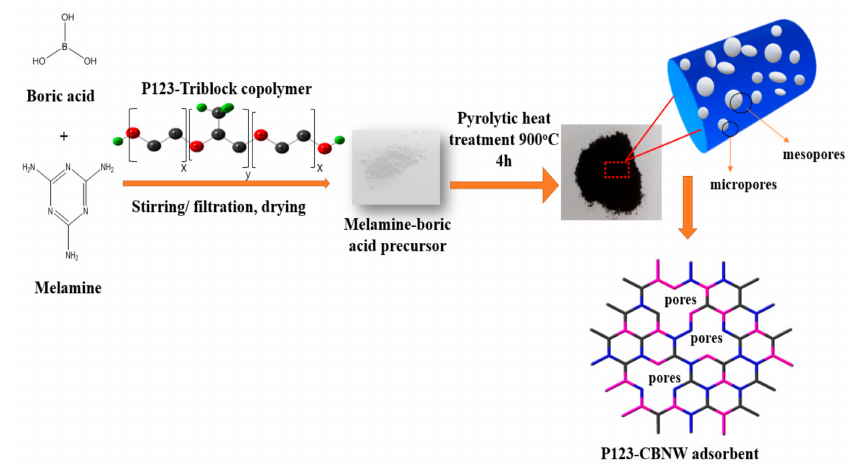
Figure 1. Schematic illustration of fabrication of P123 activated carbon containing porous boron nitride (BN)